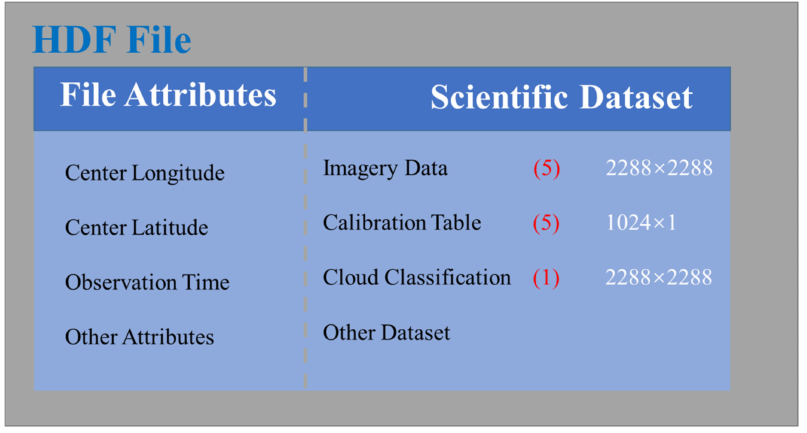
Figure 2. The structure of the data file.